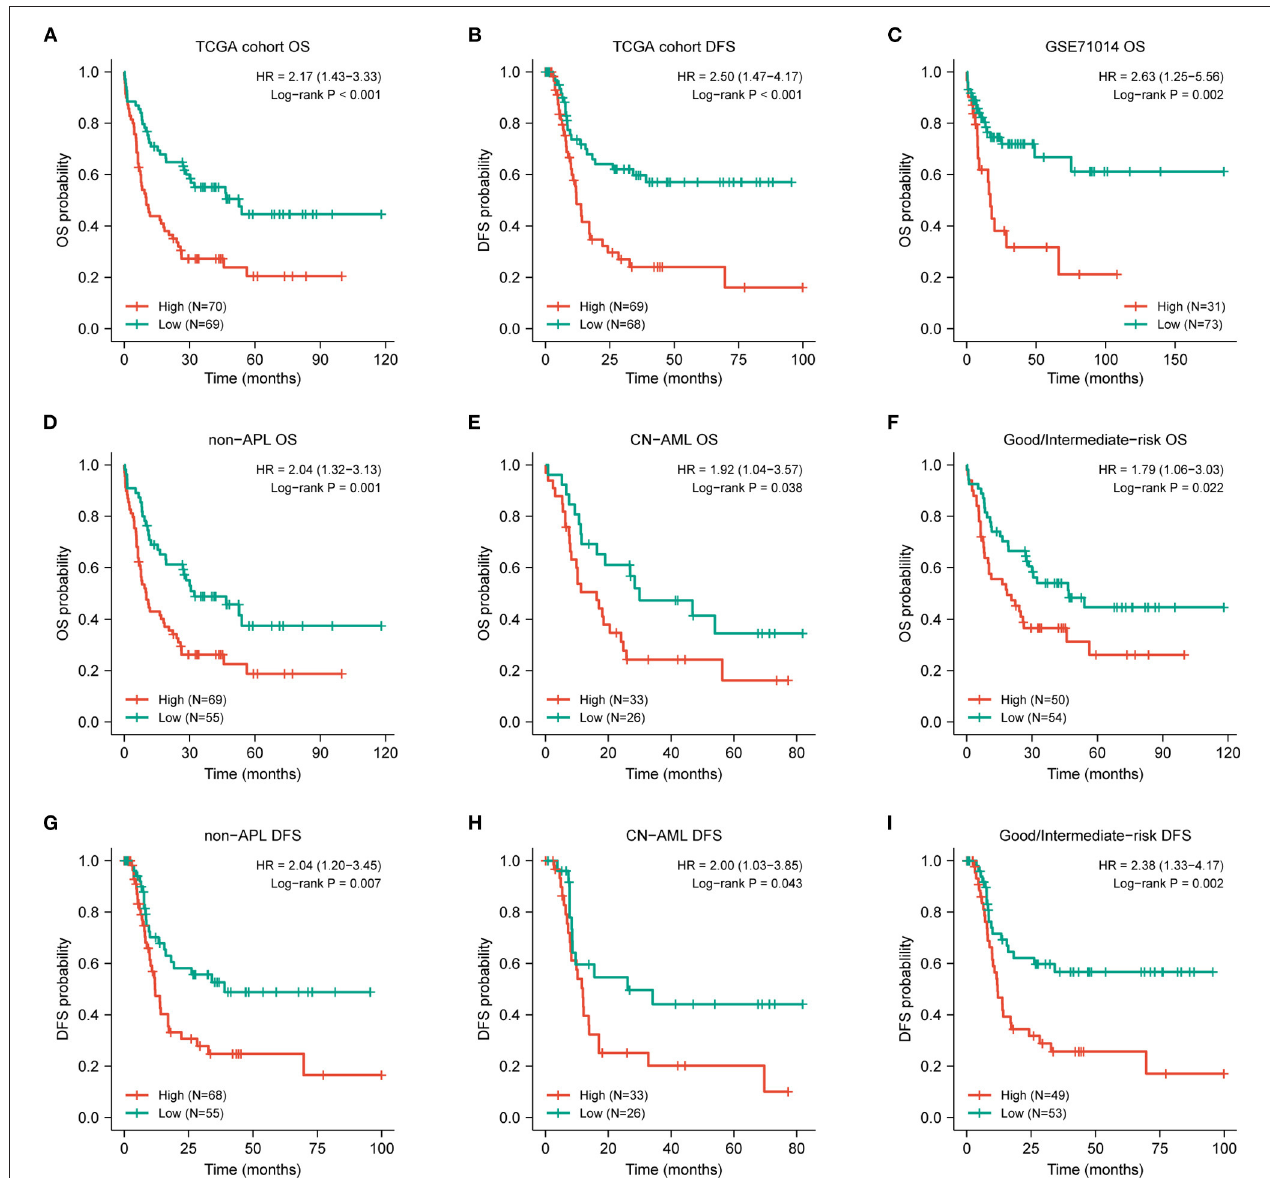
FIGURE 2 | Prognostic value of DOK2 for patients with AML. Kaplan–Meier survival analysis for (A) OS and (B) DFS in the TCGA cohort. (C) Kaplan–Meier survival analysis for AML OS in GSE71014. (D–F) Kaplan–Meier curves for OS in non-APL, CN-AML, good/intermediate-risk subsets from the TCGA cohort. (G–I) Kaplan–Meier curves for DFS in non-APL, CN-AML, good/intermediate-risk subsets from the TCGA